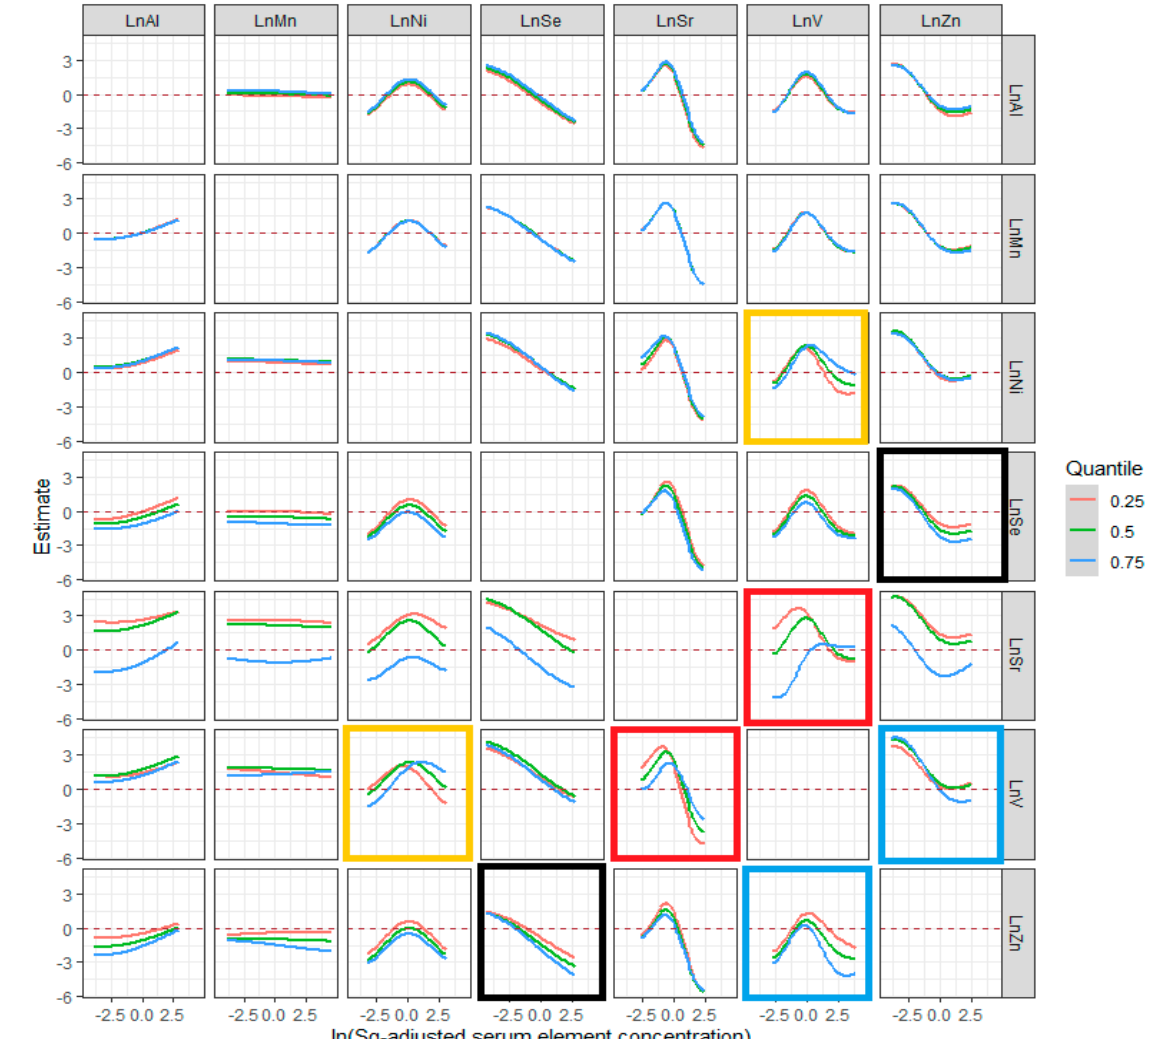
Figure 5. Exposure–response function of a single trace element (column) where the second exposure (row) was fixed at the 25th (red line), 50th (green line) and 75th (blue line) percentile. The model was adjusted for smoking, drinking and family history of EC.